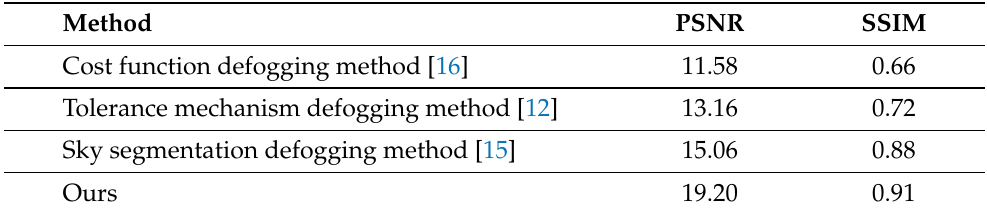
Table 3. Quantitative results of other defogging methods and our proposed method in the test